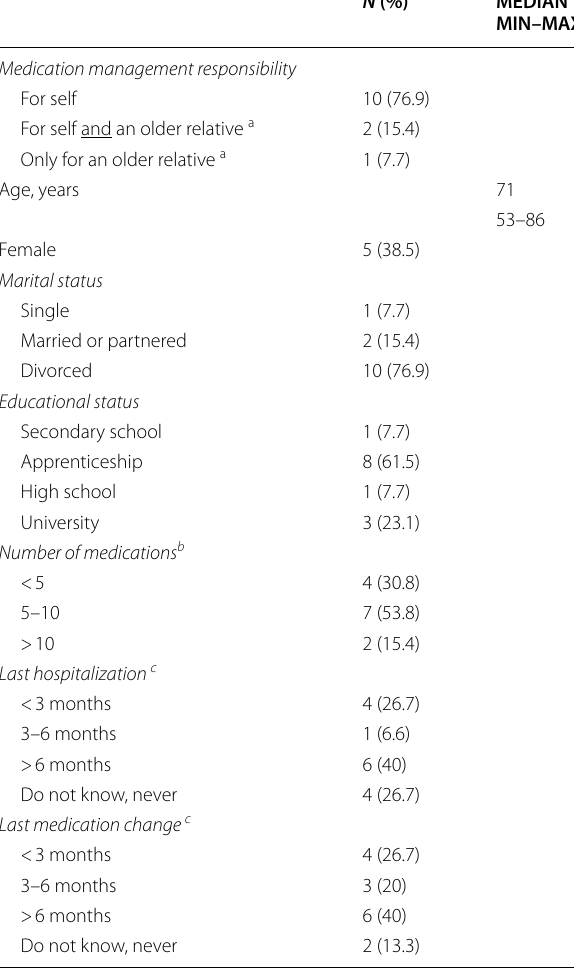
Table 1 Characteristics of home-dwelling older adults and/or informal caregivers ( N 13) =